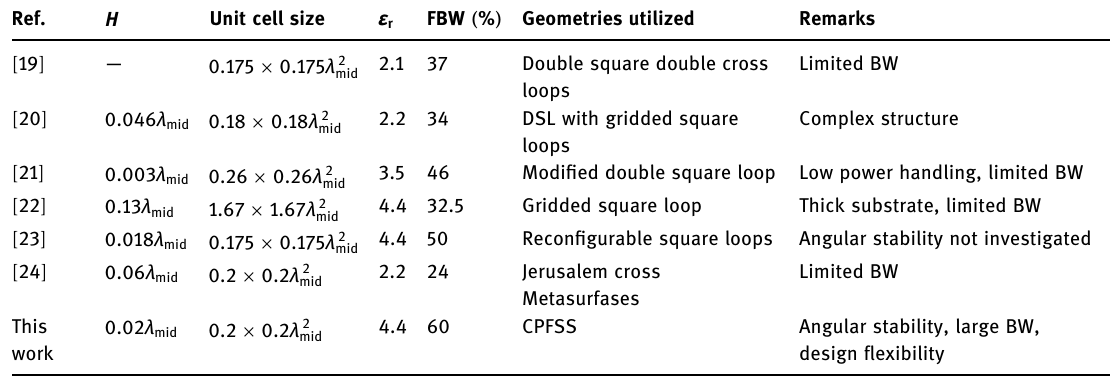
Table 2: Comparison of the proposed CPFSS design with the existing designs available in the literature